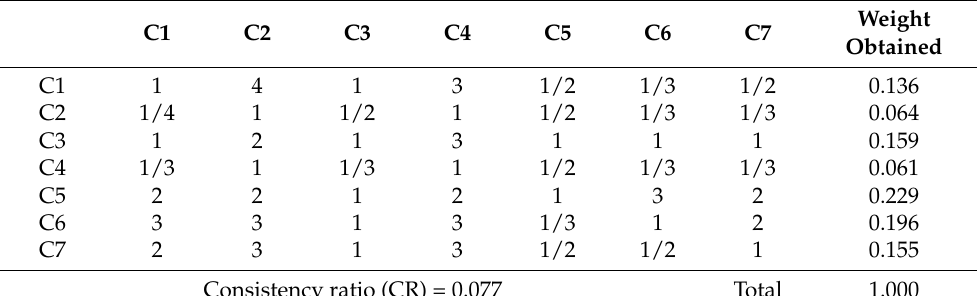
Table 5. Relative matrix importance of the criteria, CR and weights obtained to assess the degree of insuf-ficiency of the sanitary sewage